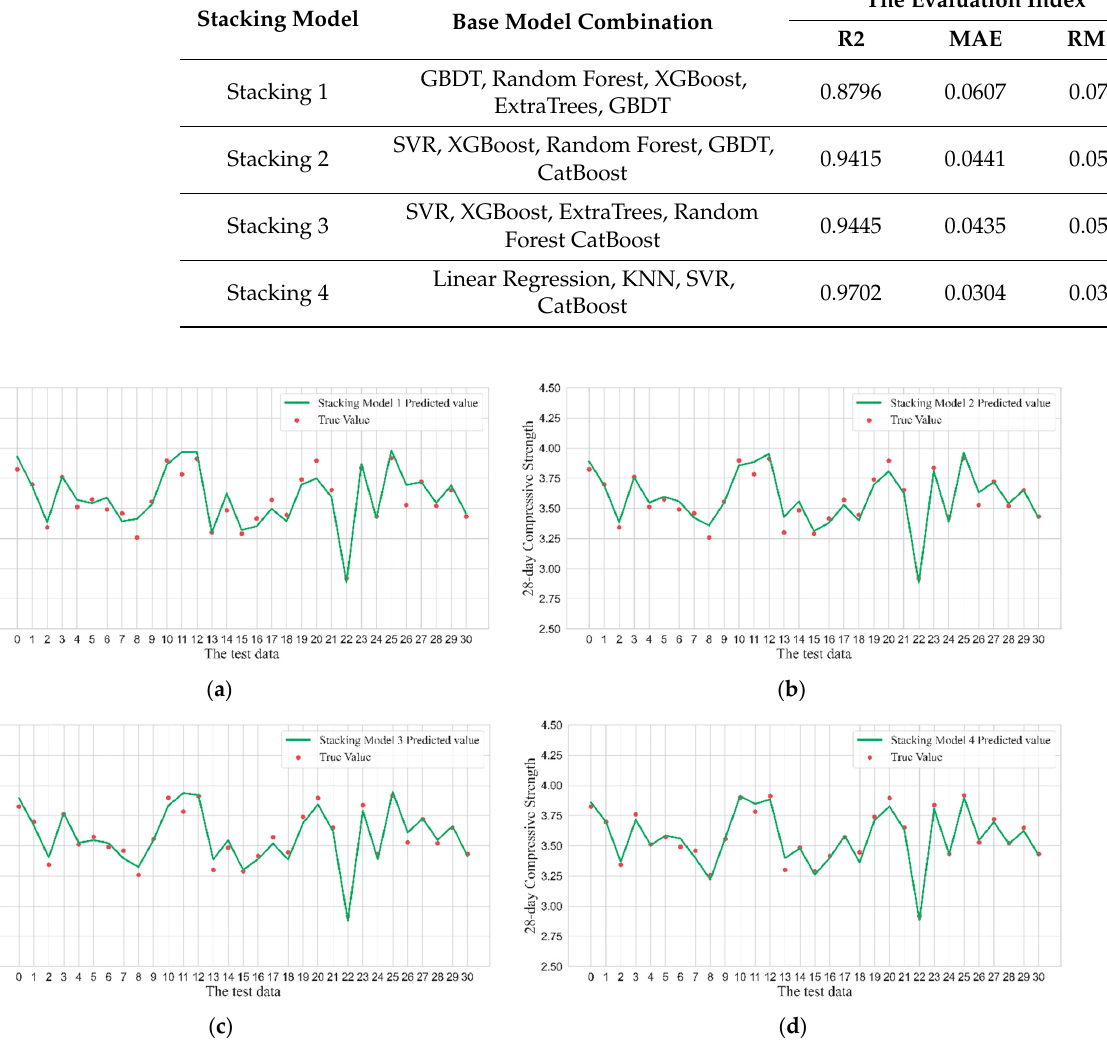
Table 10. Prediction results of different stacking models.